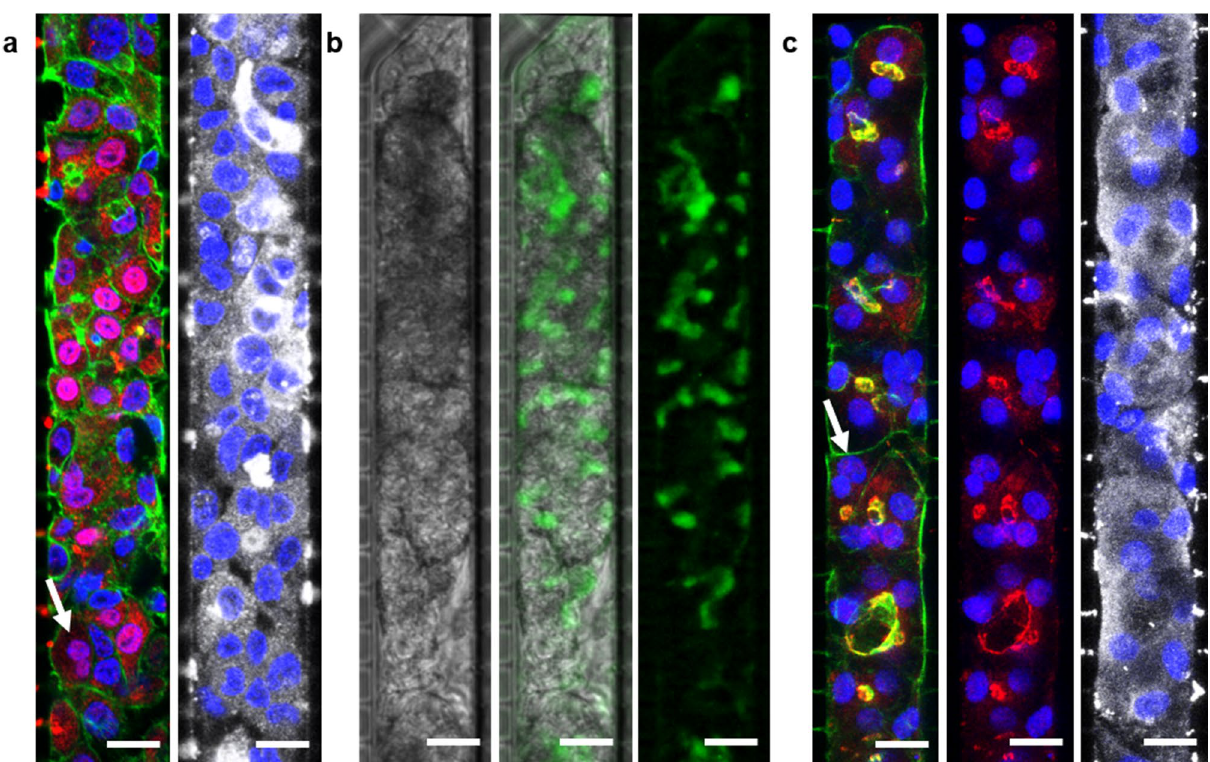
Figure 5. Immunofluorescence or DCFA staining of HepaRG cells cultured on the 40–2 µm device, revealed under epifluorescent or confocal microscopy. Top-down views of the chamber with respect to proliferative HepaRG cells loaded and cultured for 14 days ( a ) fixed and stained for nuclei (blue), F-actin (green), HNF4α (red) and albumin (grey) or ( b ) at 50 nl/min, stained for DCFA (green) and examined under phase contrast imaging. ( c ) HepaRG hepatocytes loaded and cultured for 21 days fixed and stained for nuclei (blue), F-actin (green), ZO-1 (red), and albumin (grey). Some binucleated cells can also be seen (white arrows). Scale bars = 20